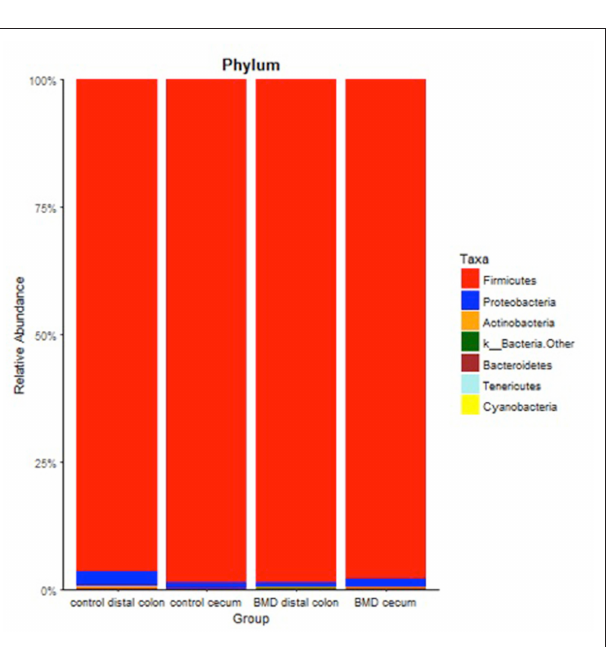
FIGURE 3 | Relative abundance at the phylum level for each of the treatment groups. Specific phyla are shown in the key on the